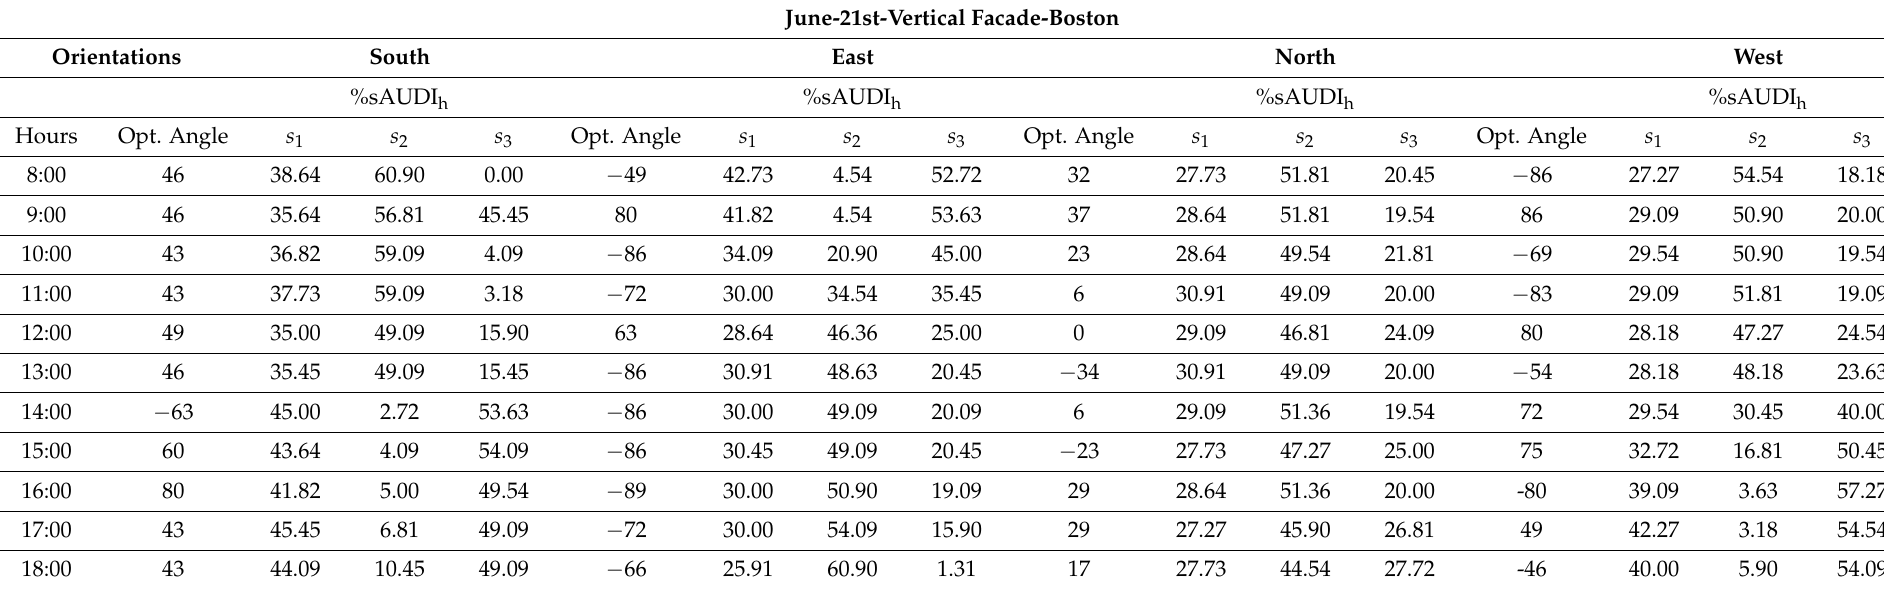
Table 9. The hourly optimum angles and their associated %sAUDI h on 21 June in Boston − Vertical louvers. June-21st-Vertical Facade-Boston